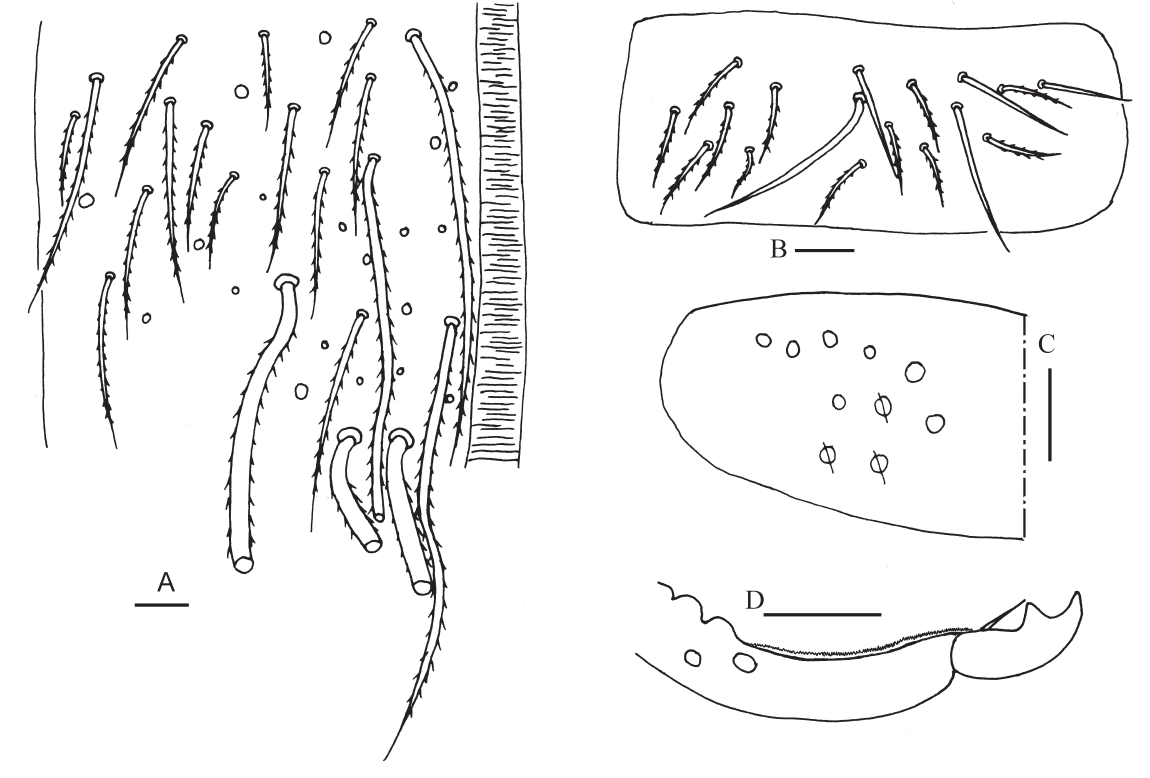
Fig. 10. Entomobrya polychaeta sp. nov. A . Anterior face of ventral tube. B . Lateral flap of ventral tube. C . Plaque of manubrium. D . Distal part of dens and mucro. Scale bars: A–D = 20